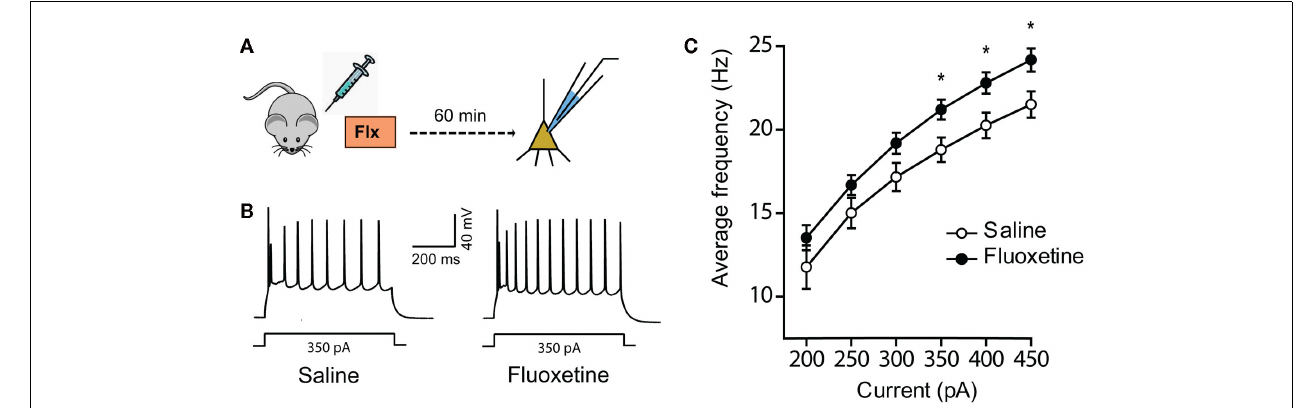
spike trains evoked by a 350-pA somatic current injection. (C) Comparison of the average f–I curves (Instantaneous firing frequency versus current; Saline: n = 11 neurons, Fluoxetine: n = 14 neurons).The instantaneous firing frequency was calculated for a series of somatic current injections from the average inter-spike interval for each current. Error bars represent SEM; * p < 0.01.